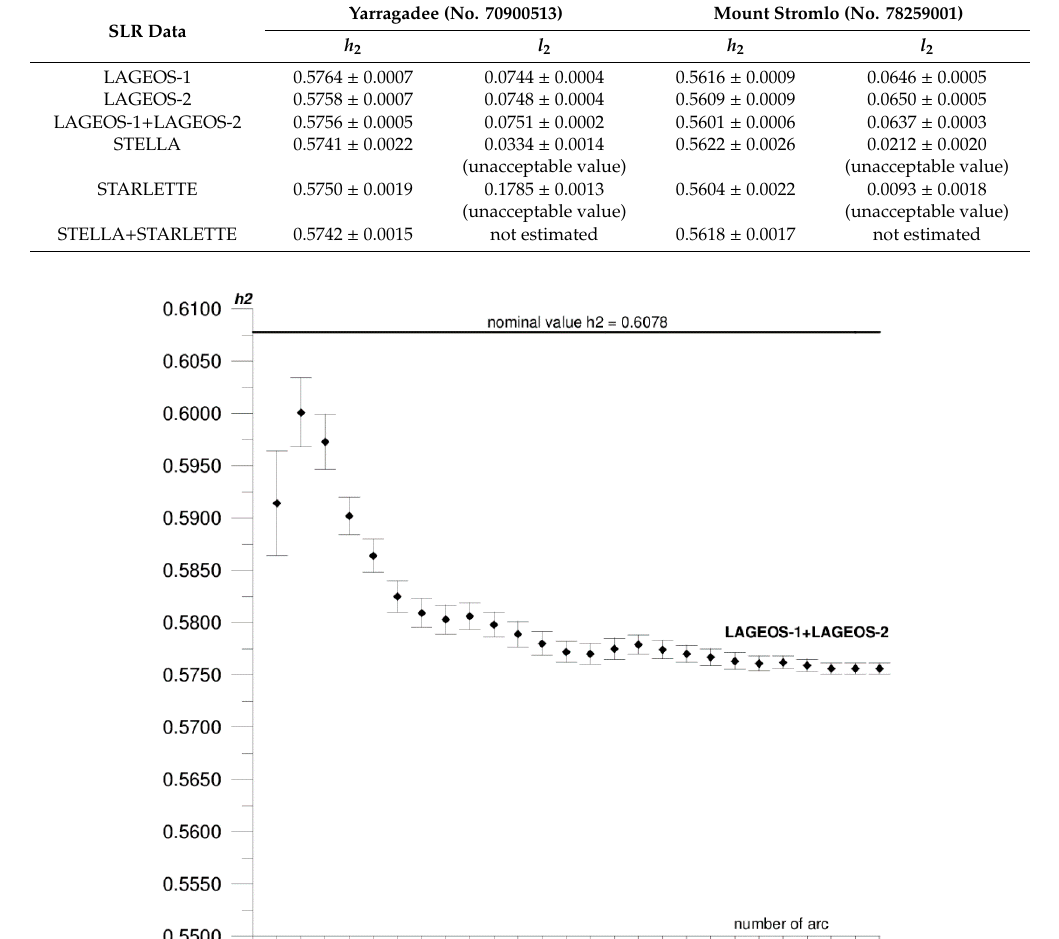
Figure 3. Sequential solution for the Yarragadee local h 2 parameter based on STELLA+STARLETTE data.